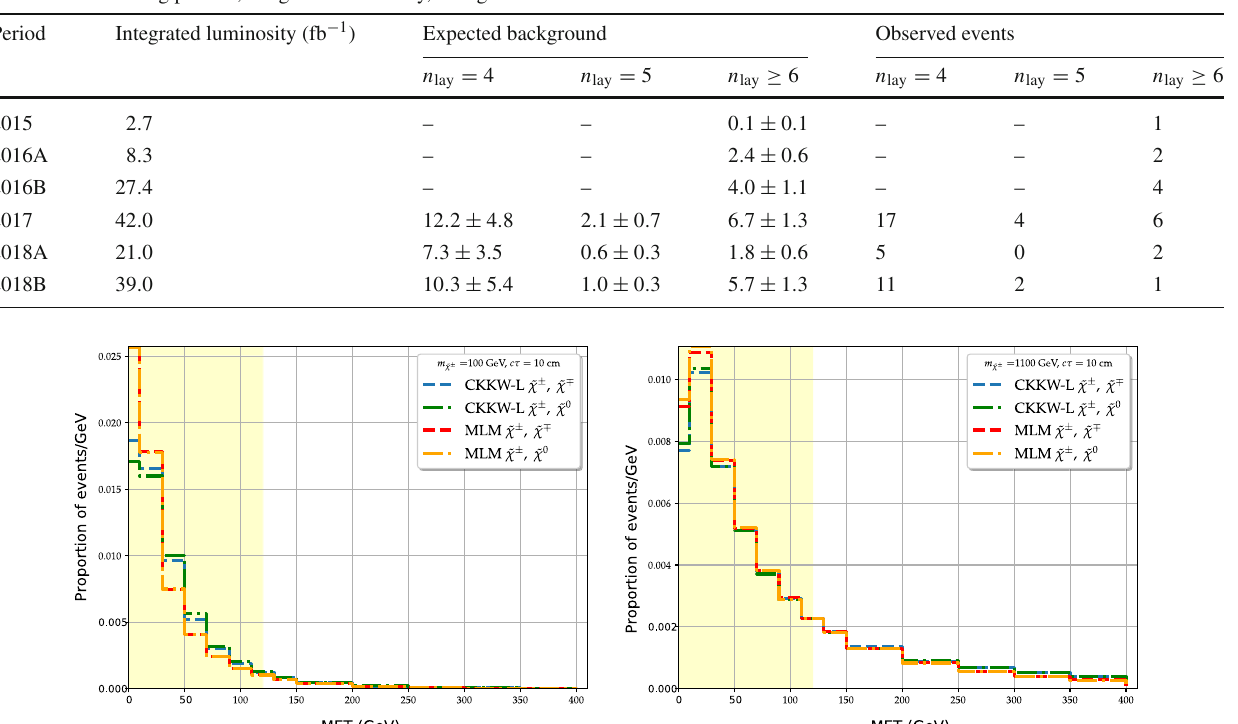
Fig. 1 Comparison of missing transverse energy distribution (propor- tion of events per GeV in each bin) for double-chargino and single- chargino events, for both CKKW-L merging and MLM matching. Left: